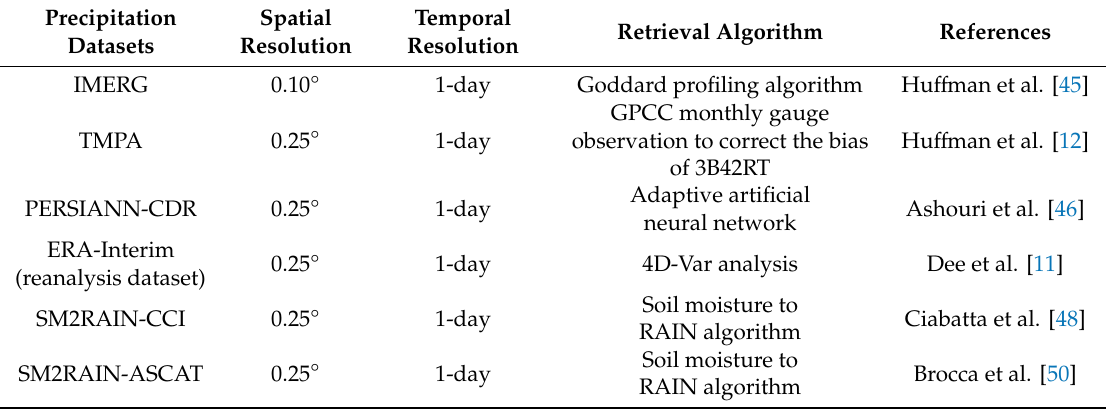
Table 1. Description of satellite precipitation datasets (SPDs) / reanalysis